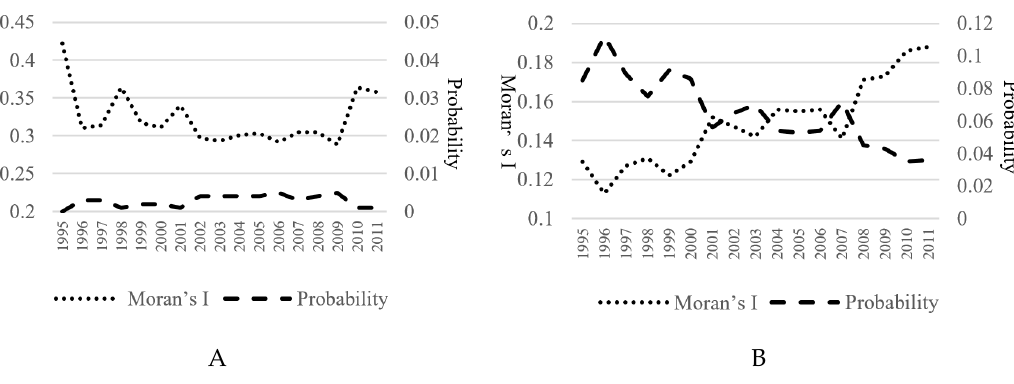
Figure 4. Global Moran’s I of the embodied GHGs in trade ( A : The EGE ; B : The EGI ). Notes: If the value of the probability is less than 0.1, 0.05, and 0.01, which means that the normal statistics of annual Moran’s I pass under the 10%, 5%, and 1% level of the significance test.